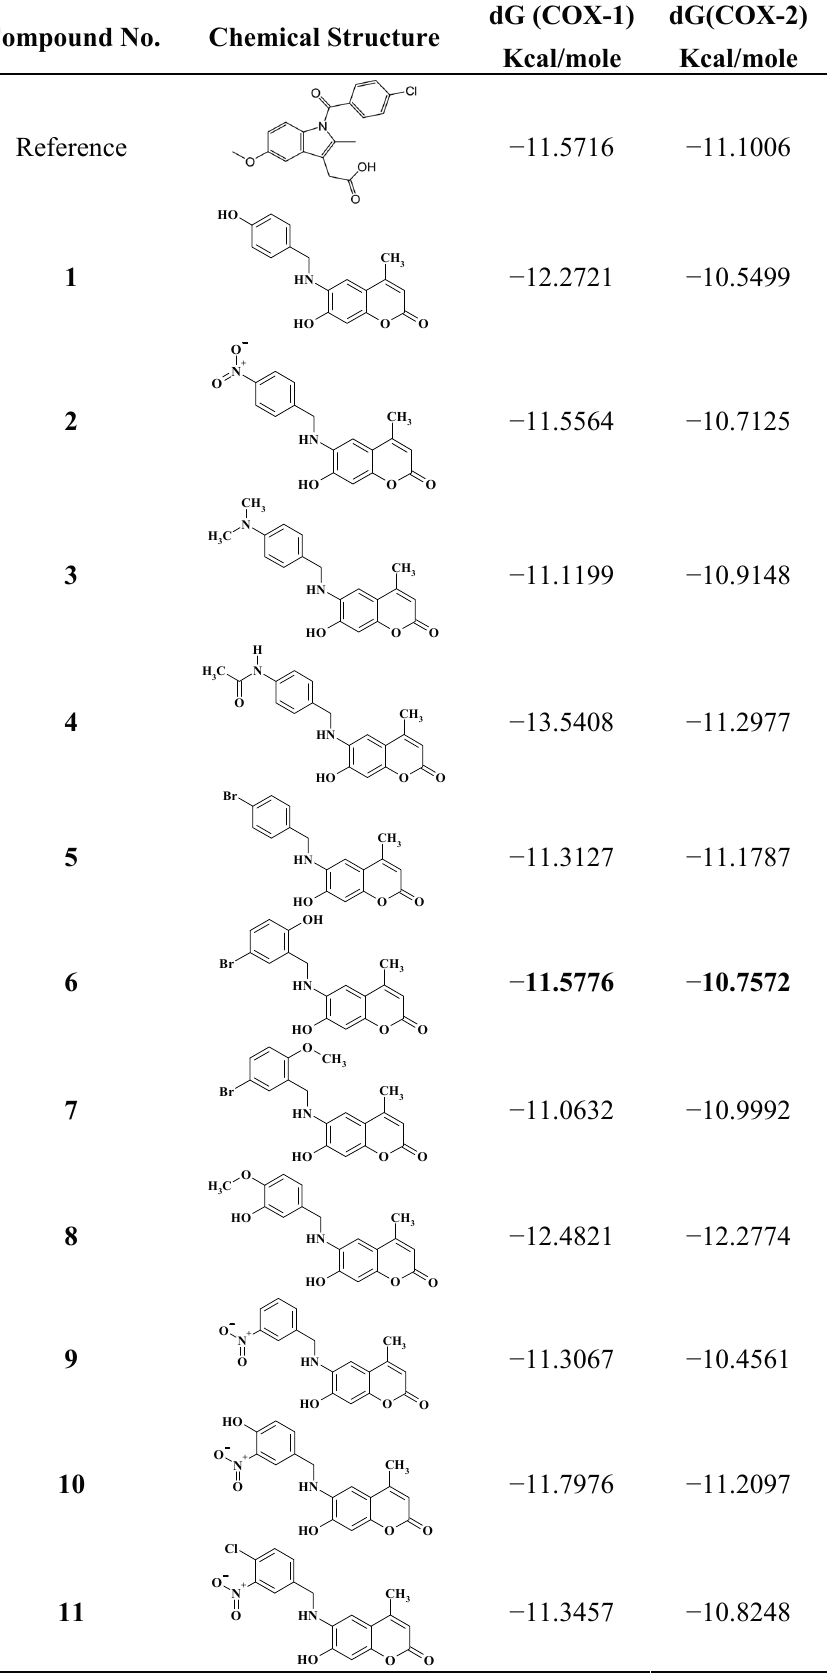
Table 3. Interaction energies of compounds 1 – 11 with the COX-1 and COX-2